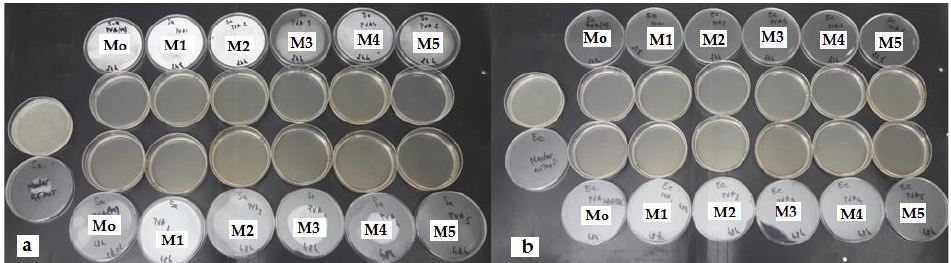
Figure 11. ( a ). Staphylococcus aureus ATCC 25923 ; ( b ). Escherichia coli ATCC 25,922 M o = PVA/XG-100/0; M 1 = PVA/XG-90/10; M 2 = PVA/XG-80/20; M 3 = PVA/XG-70/30; M 4 = PVA/XG-60/40; M 5 = PVA/XG-50/50; M. Table 3. Results of PVA/XG hydrogel antimicrobial activity testing.